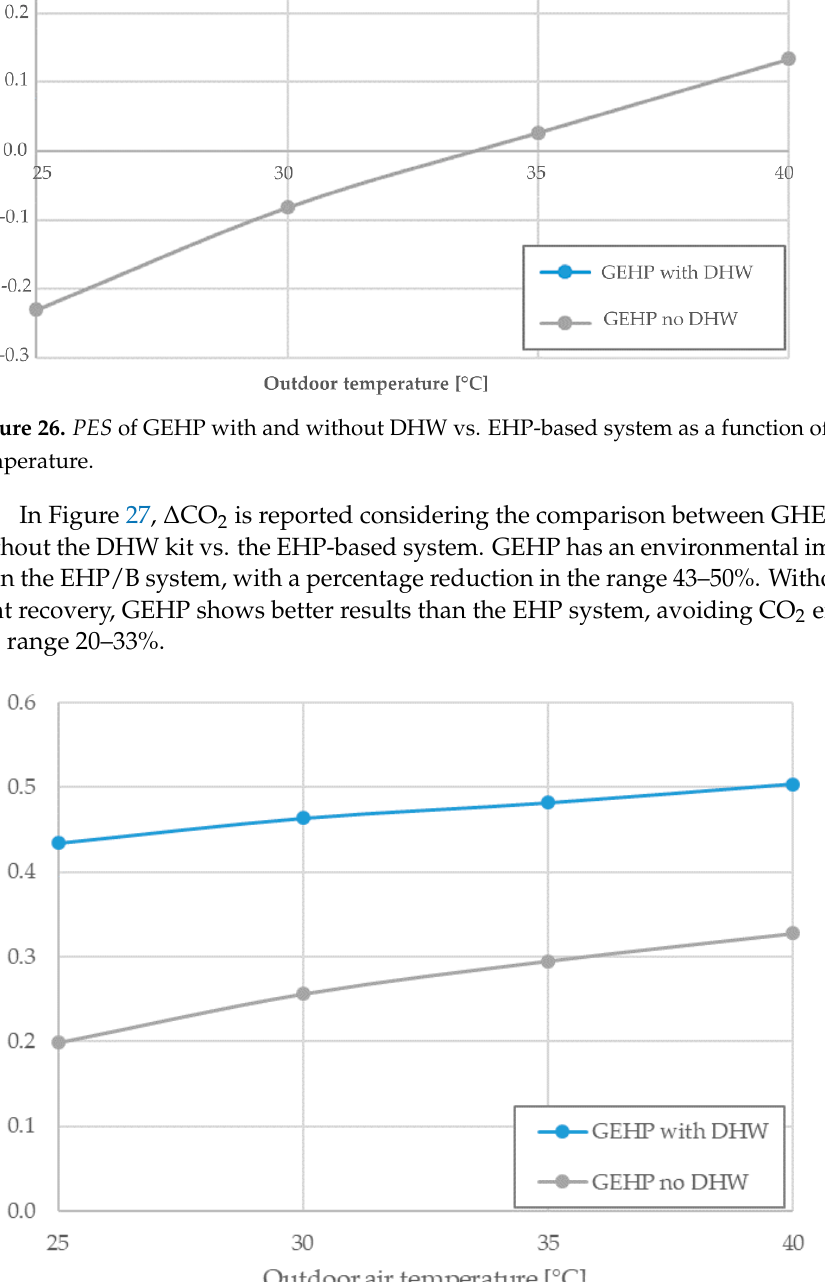
Figure 25. Comparison between GEHP with DHW kit and EHP/B.